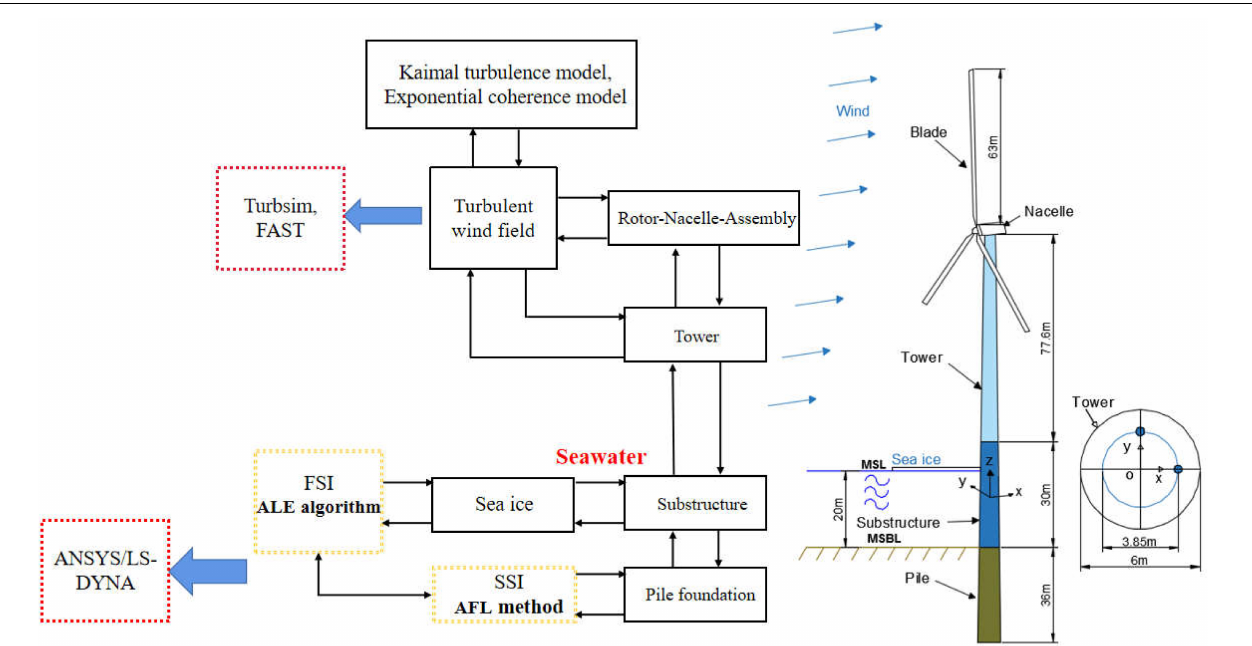
FIGURE 1 | Schematic diagram of the national renewable energy laboratory (NREL) 5 MW monopile offshore wind turbine (OWT).